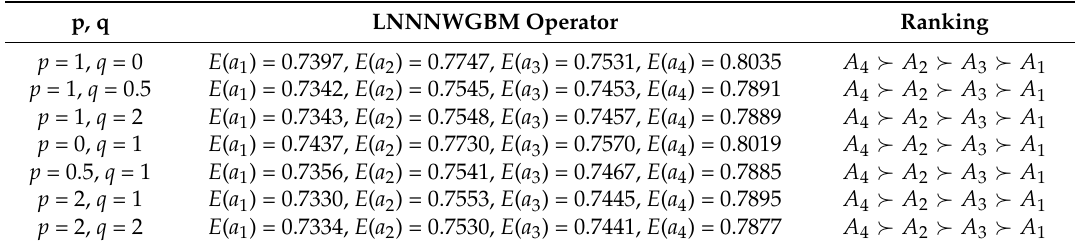
Table 7. The ranking based on the LNNNWGBM operator with the different values of p and q . LNNNWGBM Operator